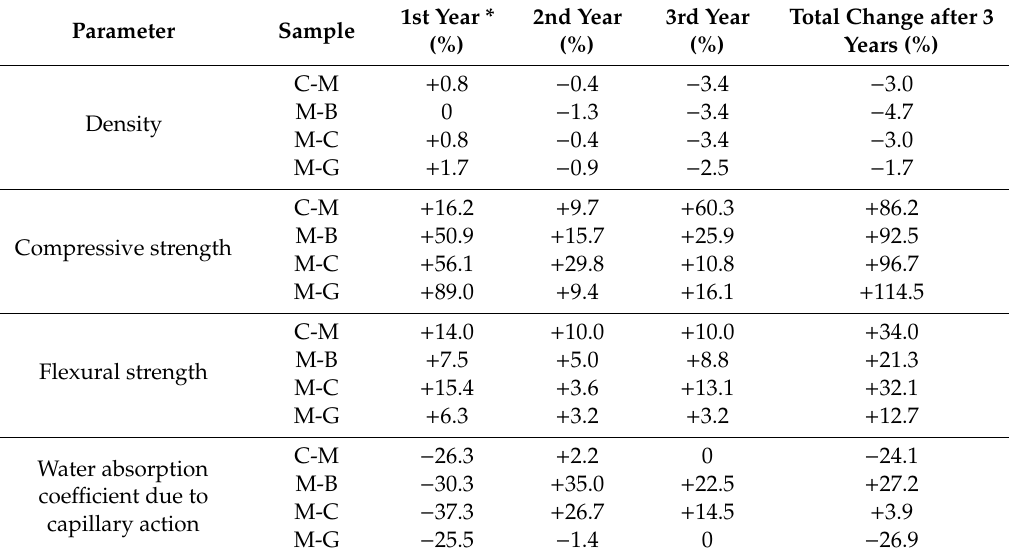
Table 3. Annual percentage increase ( + ) / decrease ( − ) of property values. Parameter